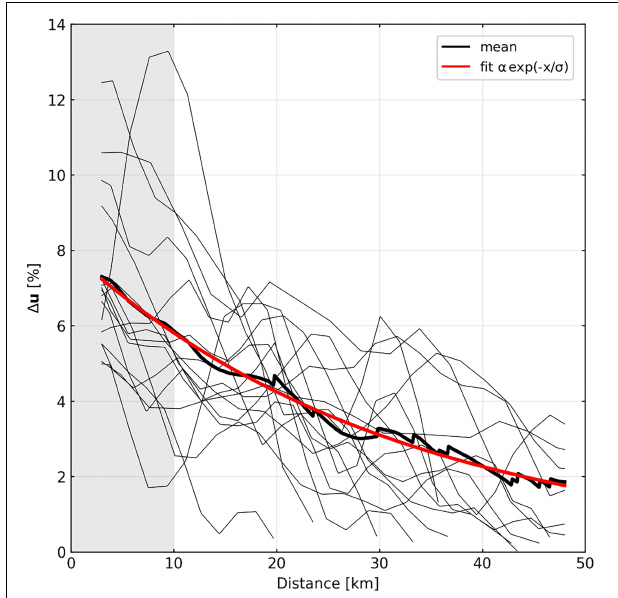
FIGURE 2 | Velocity deficit curves derived from SAR measurements for isolated wake cases at the Global Tech wind farm (thin black lines). The thick black line indicates the average velocity deficit. The red curve corresponds to the best fit of the velocity deficit considering an exponential downstream wake recovery formulation [Eq. (2)], with α = 7.5% and σ = 32